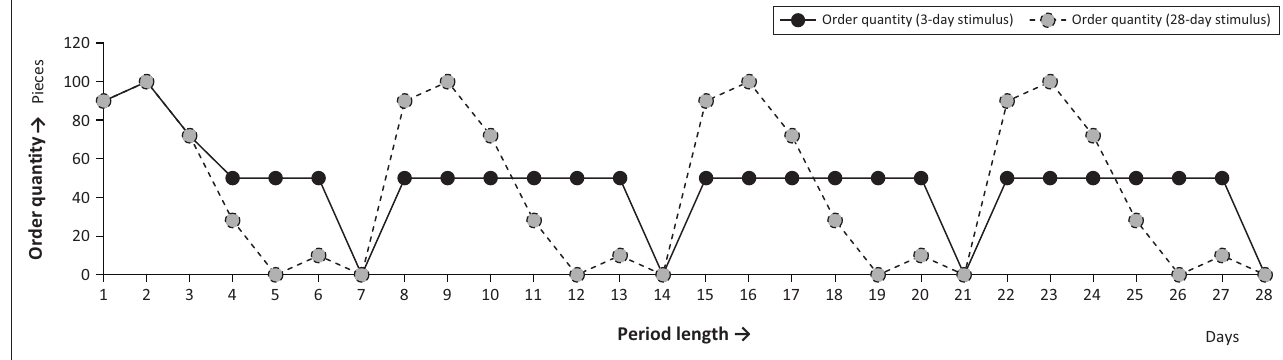
FIGURE 4: Sinusoidal stimulus for an input amplitude of 50 and period length of 3 and 28